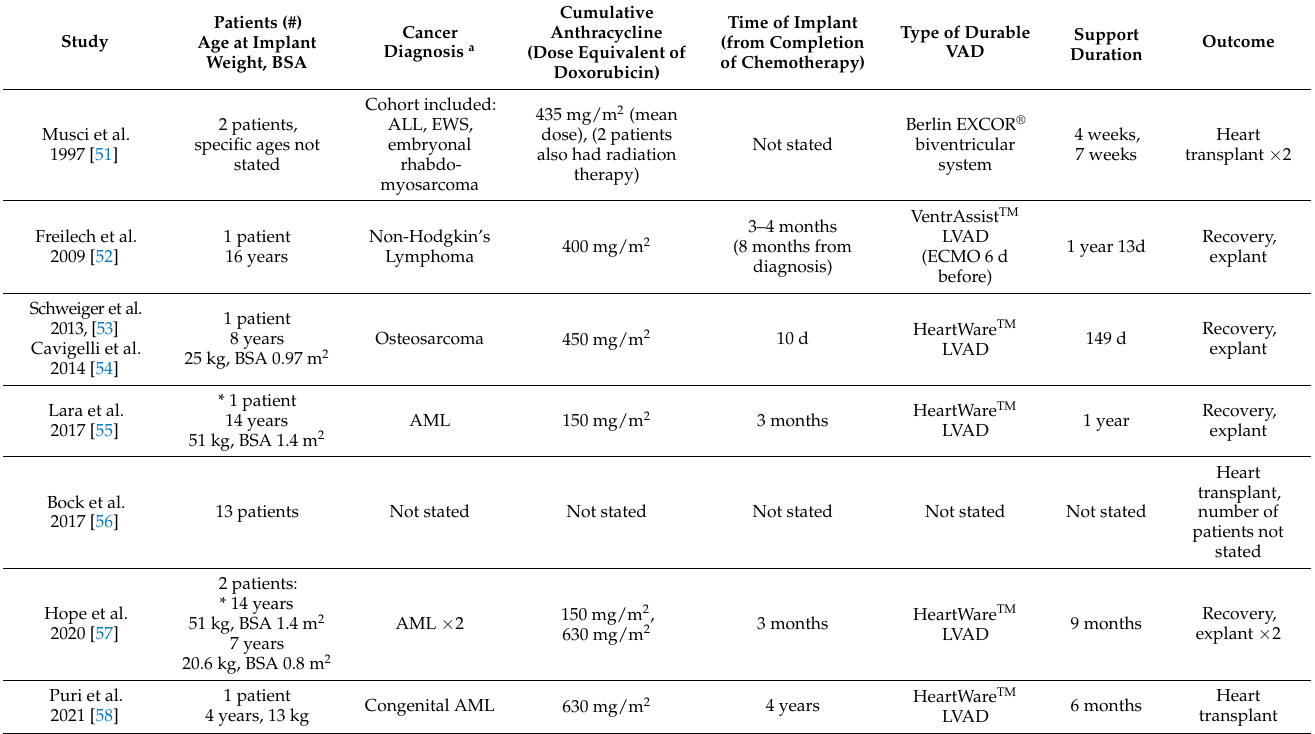
Table 1. Literature review of ventricular assist device therapy in children with chemotherapy-induced cardiomyopathy.